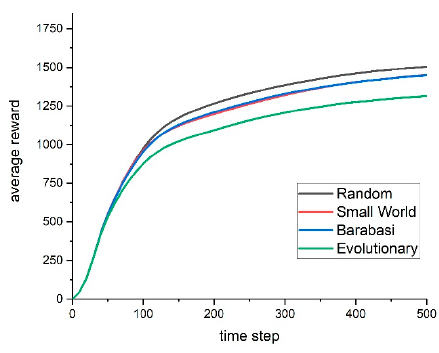
Figure 3. Average rewards for different networks over 500 simulation steps.